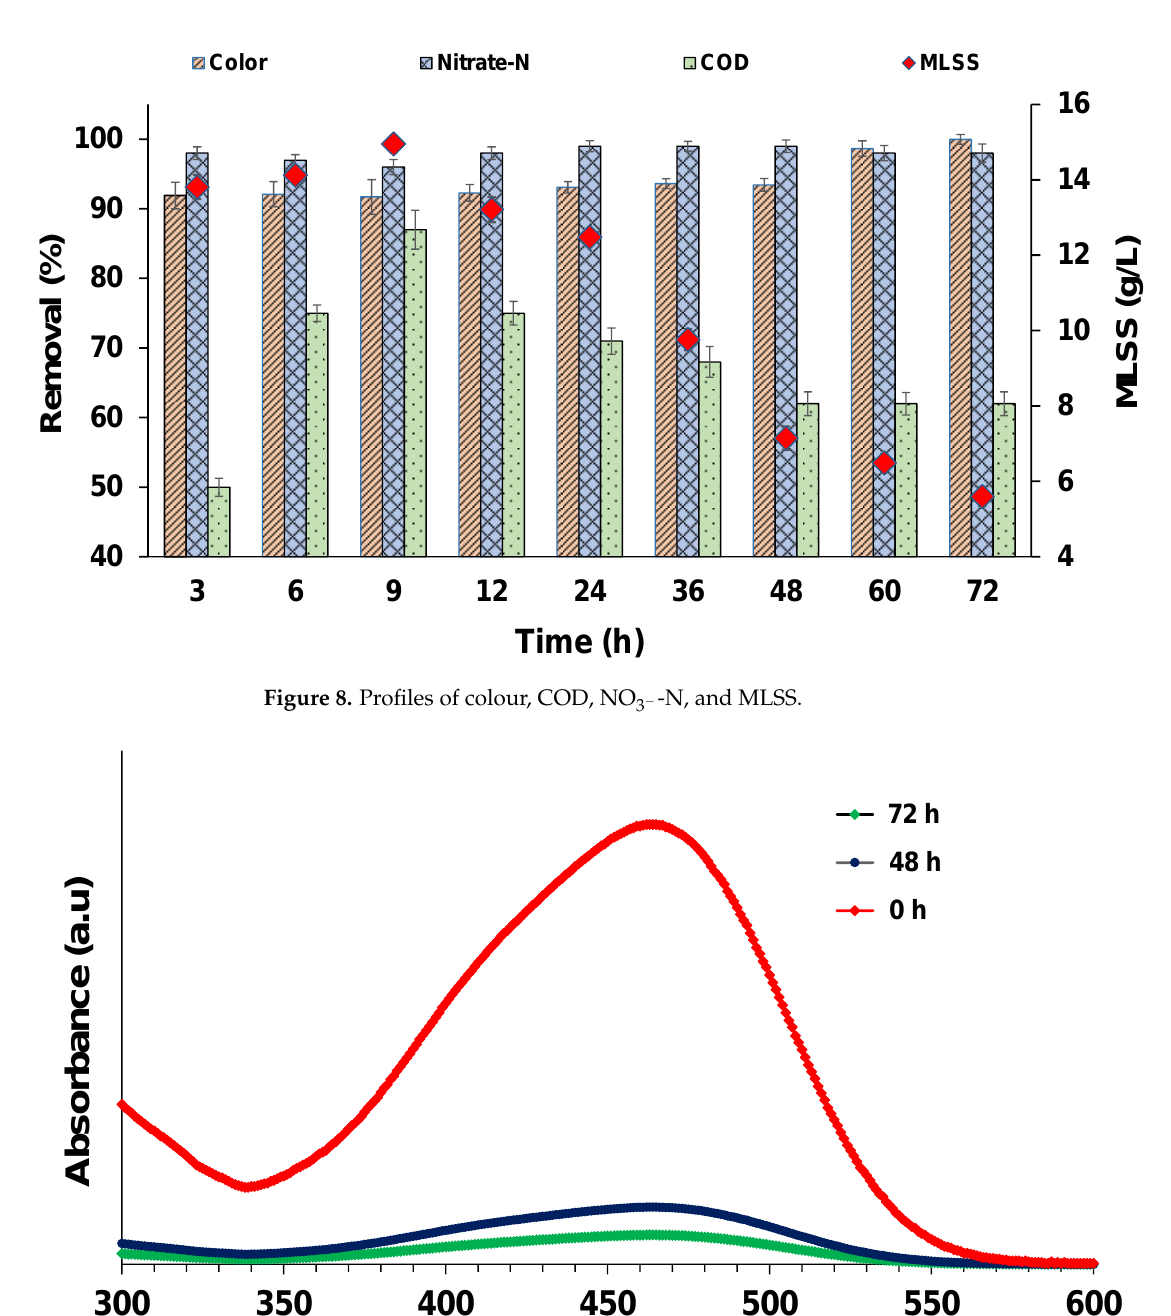
Figure 9. UV-Vis absorbance spectra of influent and effluent.